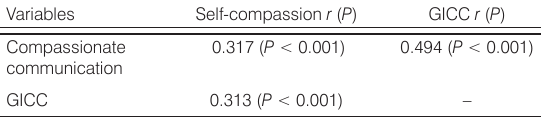
Table 4. Multi-trait multi-item matrix for convergent and discriminant validity. Table 5. Correlations among all variables ( N =